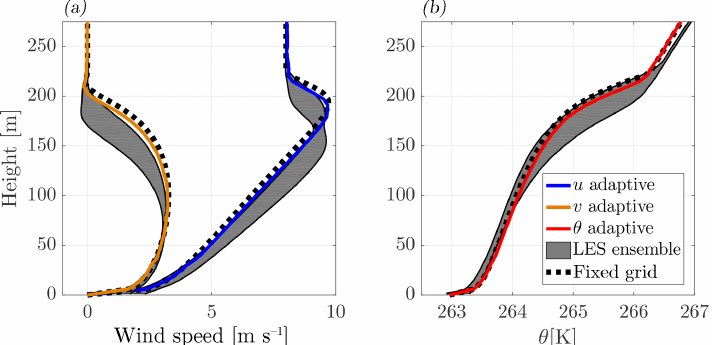
Figure 4. Time-averaged profiles over the ninth hour of the run according to the GABLS1 inter-comparison scenario. For (a) the horizontal wind components and (b) the potential temperature. Results are obtained with the present adaptive-grid SCM (coloured lines), the LES models ensemble (i.e mean ± σ ) from Beare et al. (2006) (grey-shaded areas), and the present SCM, employing an equidistant and static grid with a 6.25m resolution (dashed lines). For z > 250m, the profiles have remained as they were initialized.